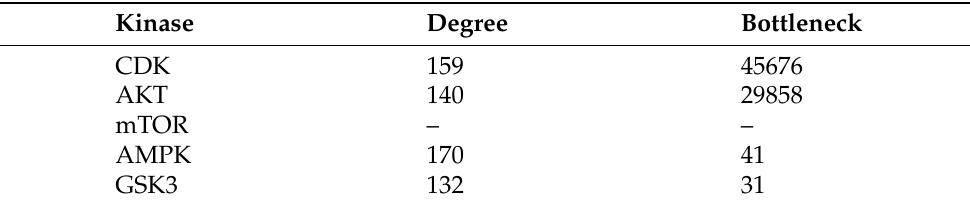
Table 4. Summary of topological metrics for the selected kinases in the protein interaction network of L. braziliensis